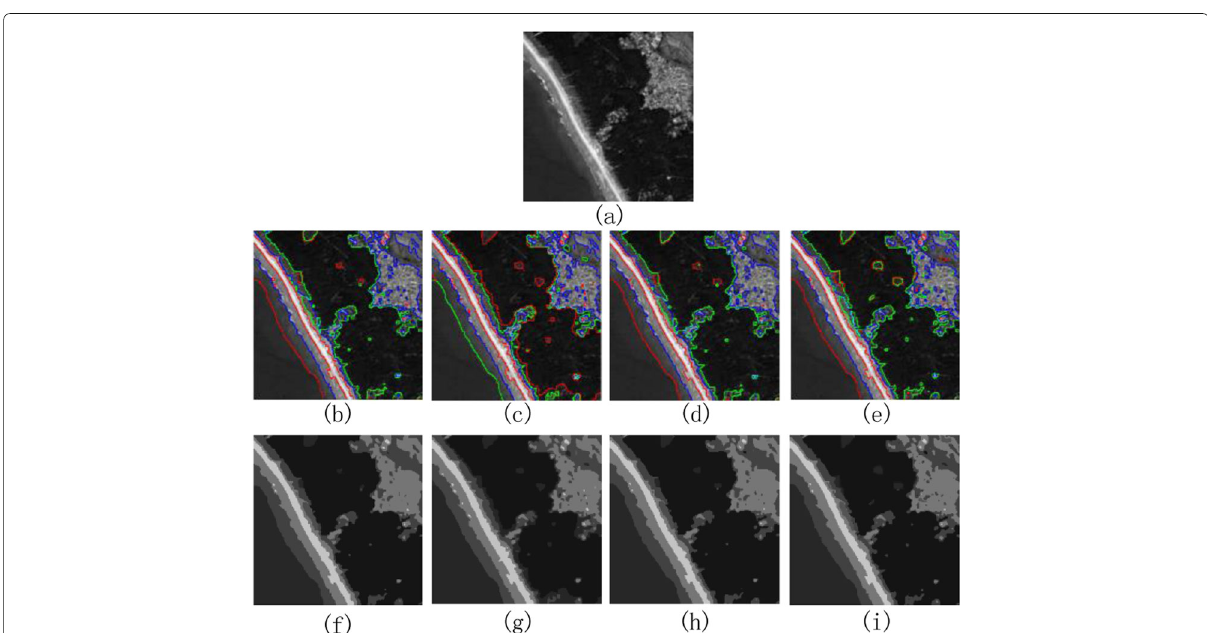
Fig. 8 Comparison of TV regularization method and our method both solved without/with acceleration method. a The remote sensing image of coastline. b – e The segmentation of TV-RWAM, our method without ADMM, TV regularization method and our method. f – i Gray images obtained via the final segmentation